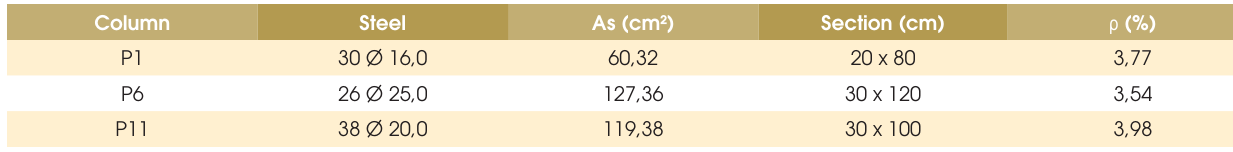
Table 3 – Dimensions and steel of columns studied for the 30-floor